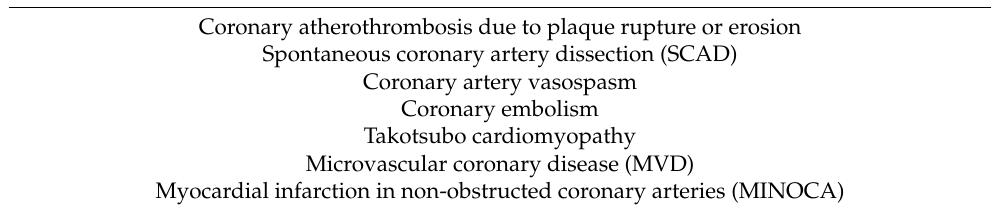
Table 1. Important differential diagnoses to consider among women of childbearing age without apparent history and/or risk factors for cardiovascular